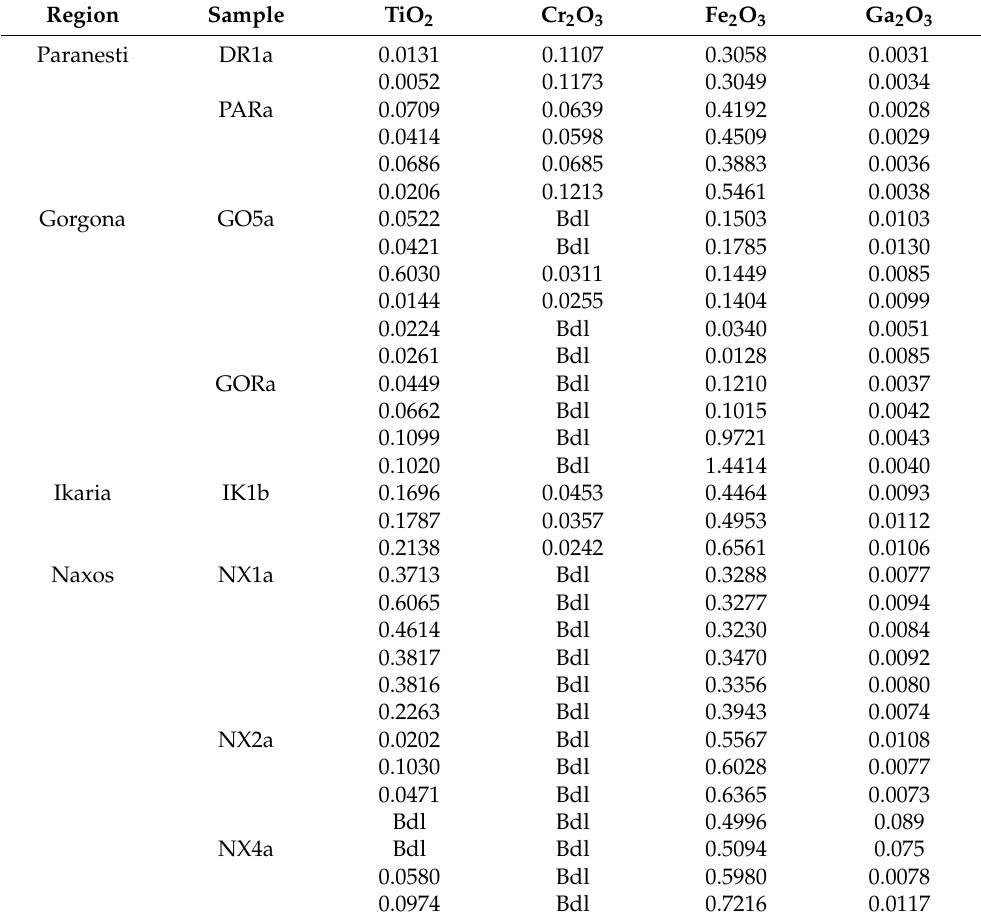
Table 1. EDXRF analyses of selected oxides of trace elements in corundum from Paranesti, Gorgona, Ikaria and Naxos (Kinidaros) in wt. %. Analyses were acquired on different colored points; Bdl: below detection